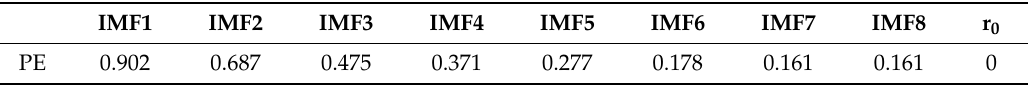
Figure 6. The permutation entropy (PE) distribution of the intrinsic mode functions (IMFs). Table 3. Permutation entropy (PE) values of intrinsic mode functions (IMFs) decomposed by fast ensemble empirical mode decomposition (FEEMD) algorithm.